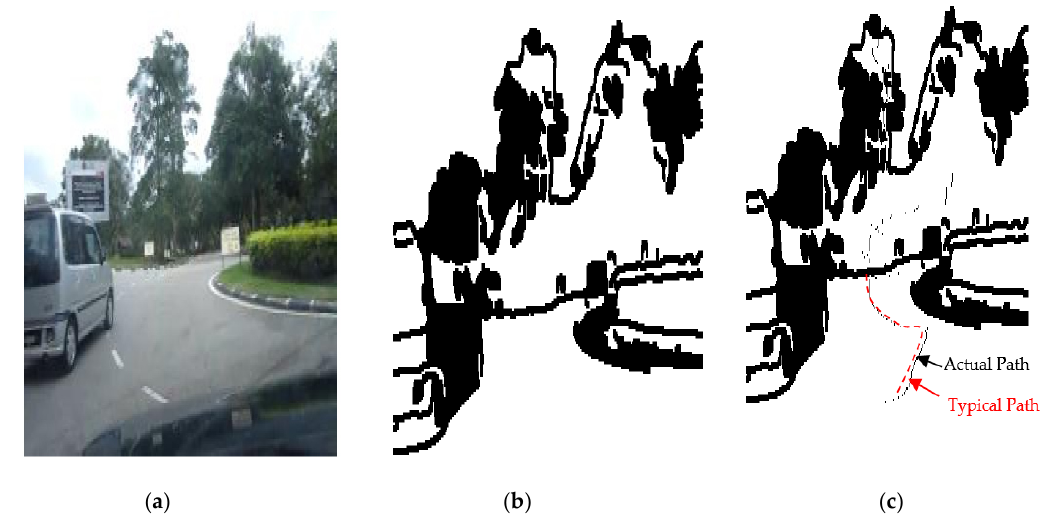
Figure 22. Autonomous detection and navigation of the proposed system in the road roundabout